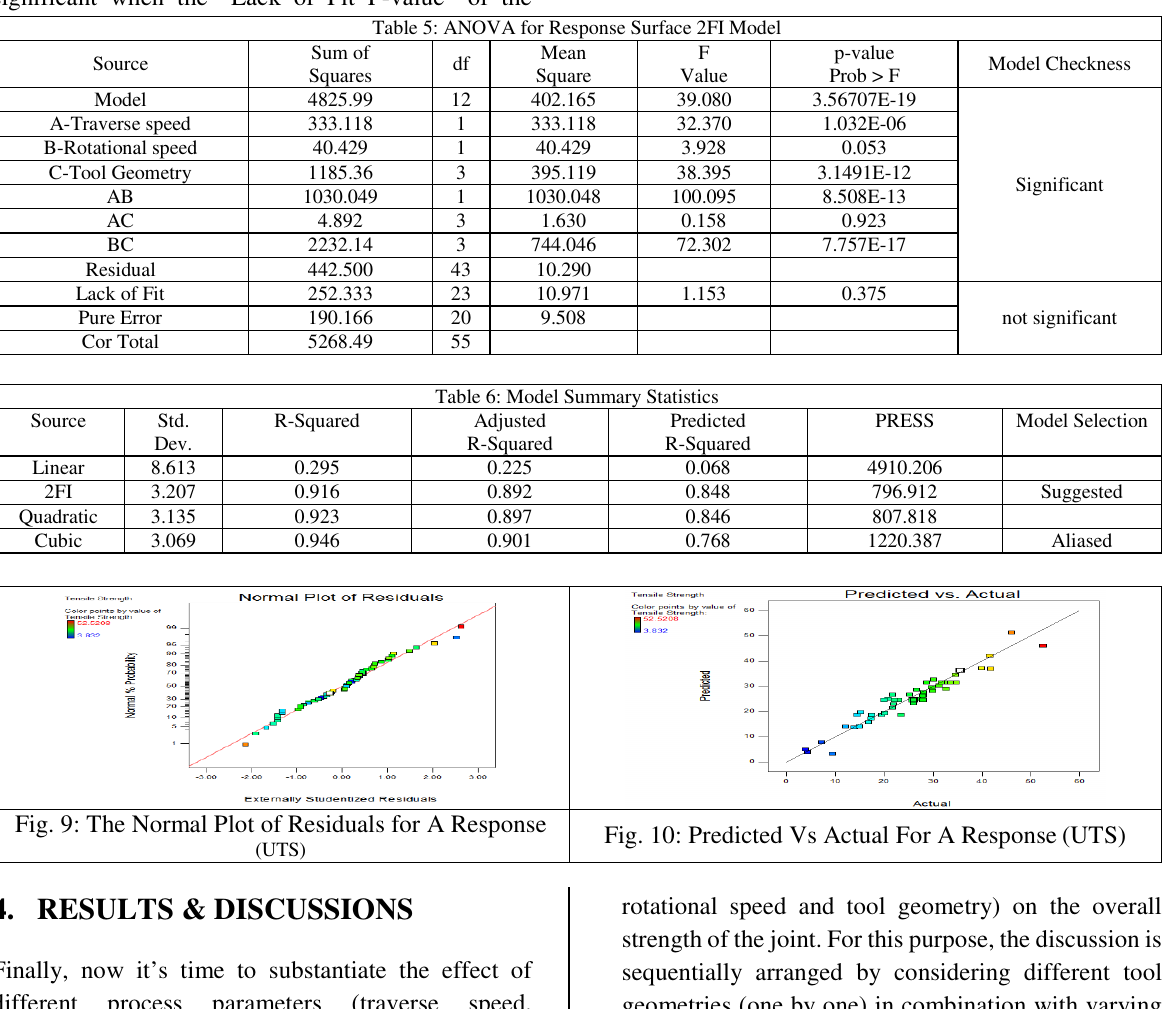
Table 5: ANOVA for Response Surface 2FI Model